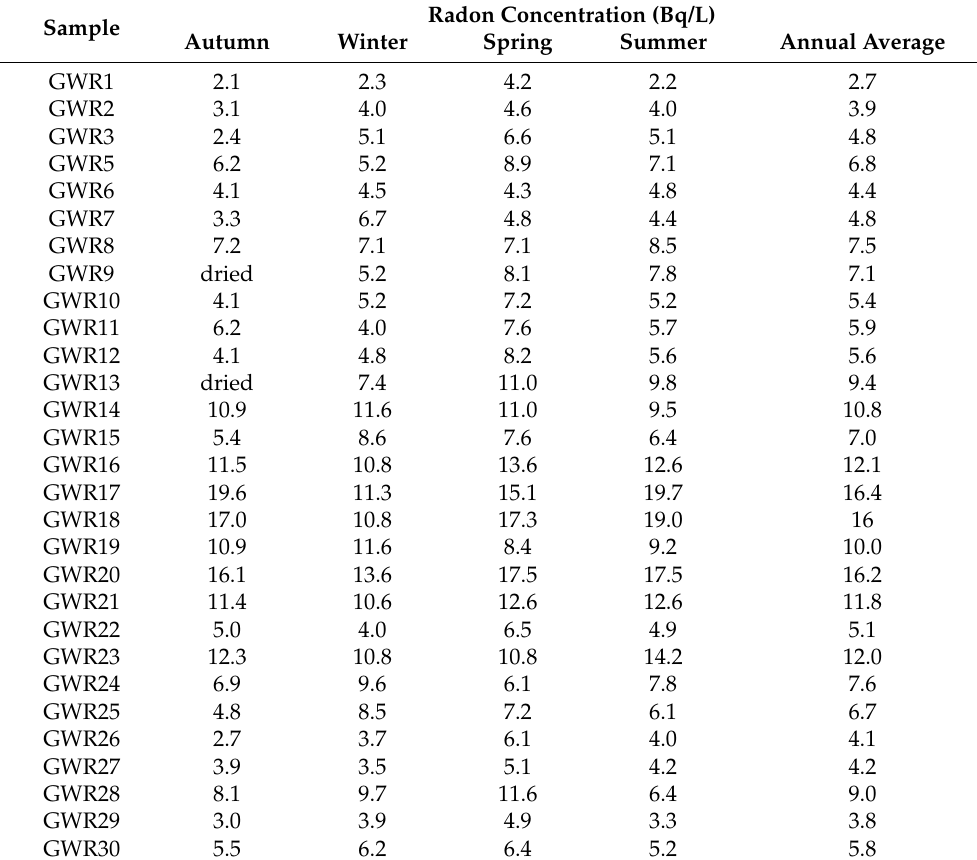
Table 2. Temporal variability of the radon activity concentration in the studied karstic springs.